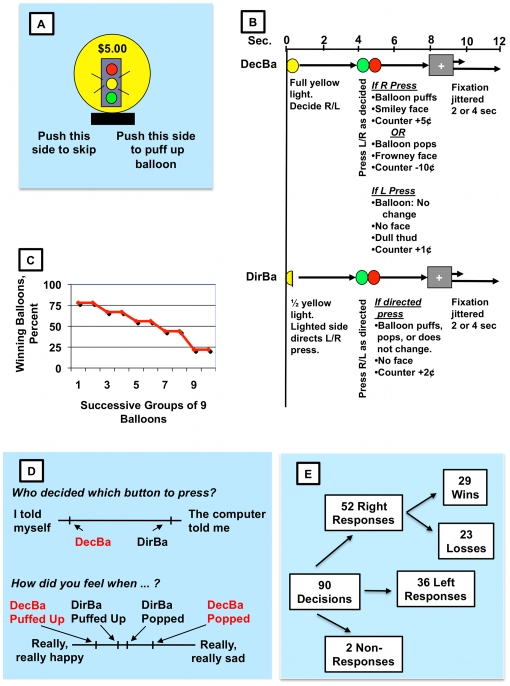
Colorado Balloon Game.
A. Decision-Balloon screen, yellow light illuminated. Counter initially $5. B. Events during presentation of 90 paired trials, each Decision Balloon (DecBa) followed by a Directed Balloon (DirBa). Top: timing (seconds). Colored circles represent stoplight lights. DecBa begins (B, upper): yellow light illuminated 4 sec, subject decides to press left (L) or right (R) button. Green light (0.5 sec), subject executes response. Red light, consequence appears (3.5 sec). Risky right press consequence, either: (a) “smiley face”, expanding balloon, puffing sounds, counter adds 5 cents, or (b) “pop” sound, shrinking balloon, “frowney face”, counter loses 10 cents. Cautious left press consequence: +1 cent on counter, dull “thud” sound, unchanged balloon. Then, “jittered” fixation. DirBa's (B, lower) are identical to their paired DecBa's except: only half of initial yellow light illuminates, signaling (i) start of a DirBa and (ii) button to press during green light (e.g., right illumination – press right) – the same button chosen during preceding paired DecBa. Green-light press on directed button: +2 cents on counter. Then balloon repeats the consequence (puff up, pop, or no change) of previous paired DecBa; subject was told that DirBa consequences would not affect earnings. Finally, jittered fixation screen. C. During DecBa, declining proportion of right presses programmed to win as game progresses. Mostly pressing left later in game saves earnings. D. Visual Analog Scales (VAS). After sessions subjects rated their opinions about the stated questions on 100mm lines. Marked positions represent all-subject means; groups did not differ significantly. Upper VAS: subjects' understanding of decision-making source for DecBa vs. DirBa. Lower VAS: Different emotional responses to puff-ups or pops of DecBa, vs. DirBa. E. Mean numbers, DecBa selections.